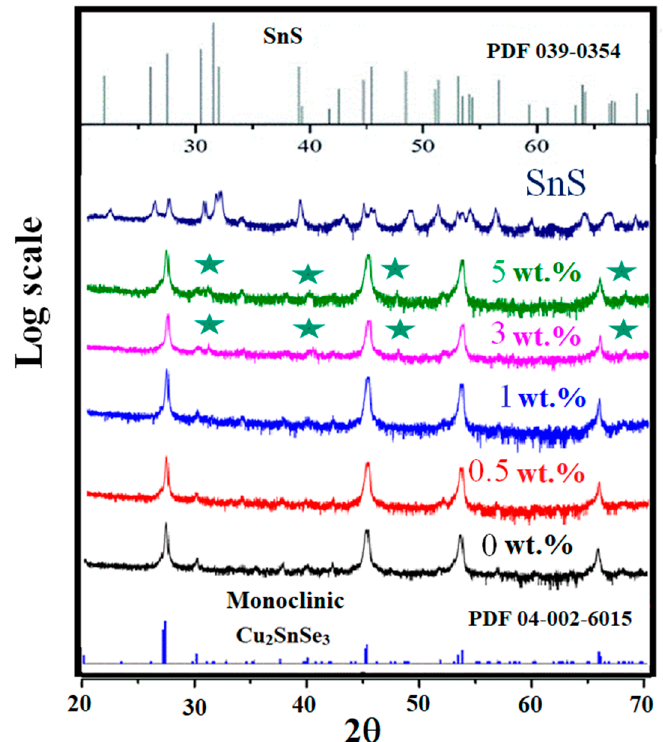
Figure 1. X-ray diffraction (XRD) patterns of Cu 2 SnSe 3 -SnS composite samples spark plasma sintered at 670 K. The bottom and top spectra represent the XRD patterns of CTSe and SnS, respectively, while the other spectra show those of composite samples. Minor peaks indicated by stars in the patterns of 3 and 5 wt% samples correspond to the SnS phase.